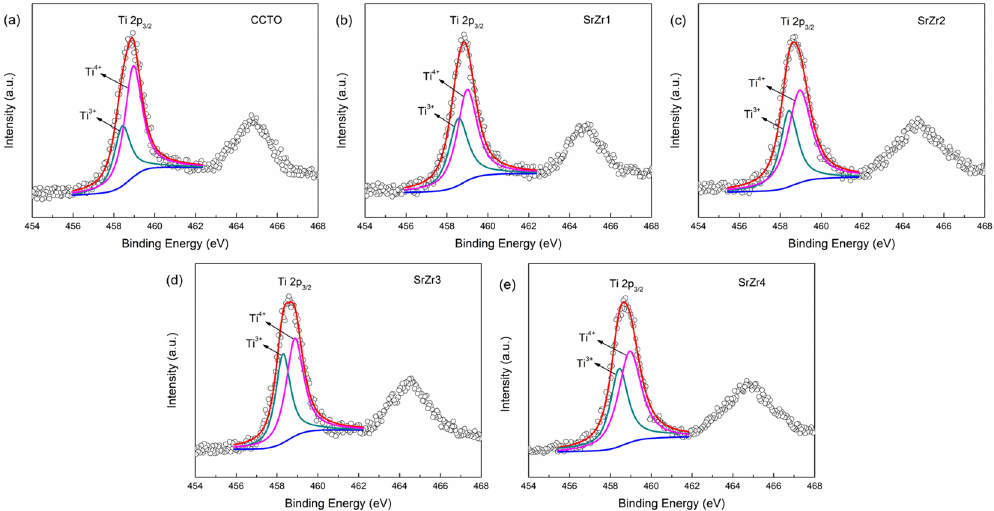
Figure 4. XPS Ti 2p spectra obtained for the as-prepared ceramics: ( a ) CCTO; ( b ) SrZr1; ( c ) SrZr2; ( d ) SrZr3; ( e ) SrZr4.